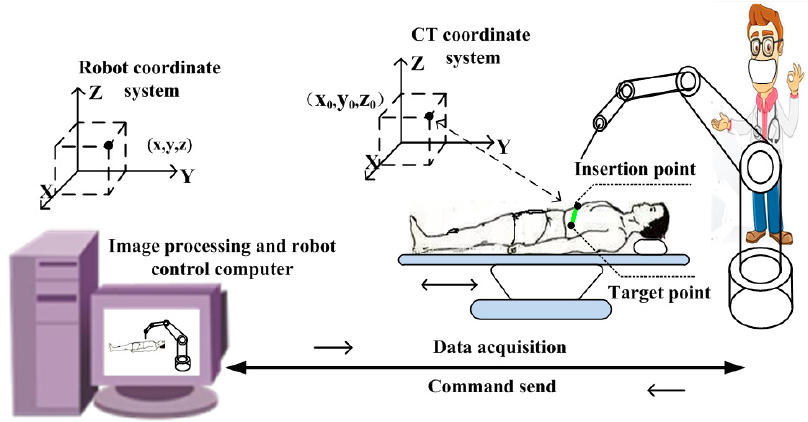
Figure 1. Position principle of the puncturing robot.